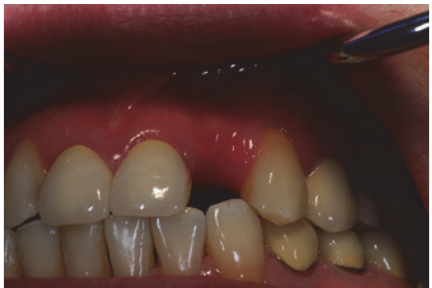
Figure 1: Initial presentation of the cantilever bridge in the maxil- lary anterior region.